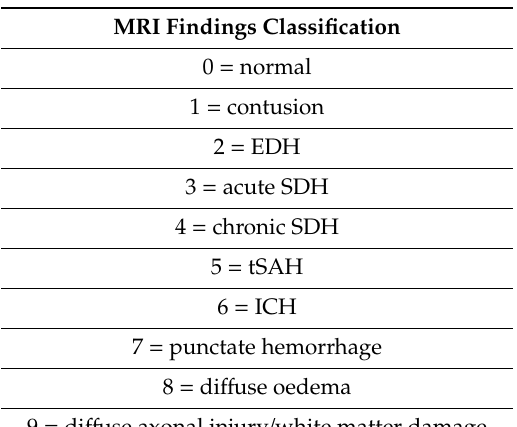
Table 4. Injury classification of the MRI